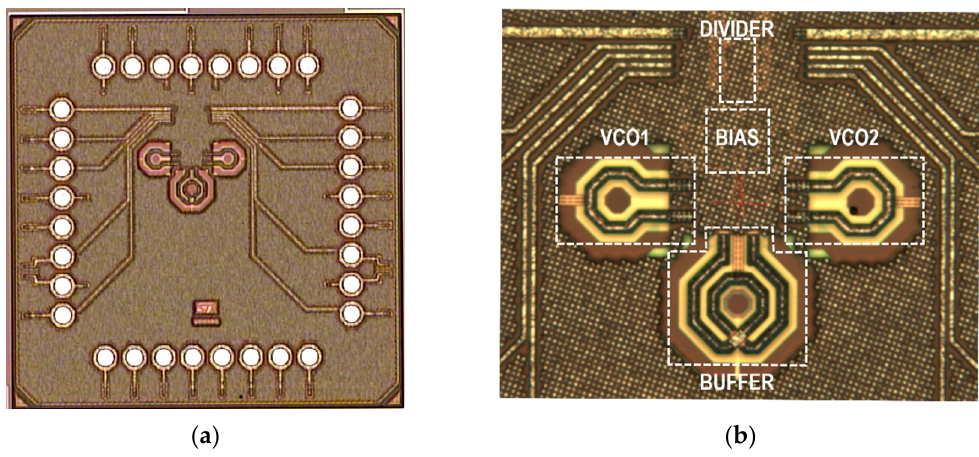
Figure 7. ( a ) Die microphotograph; ( b ) VCO core detail.